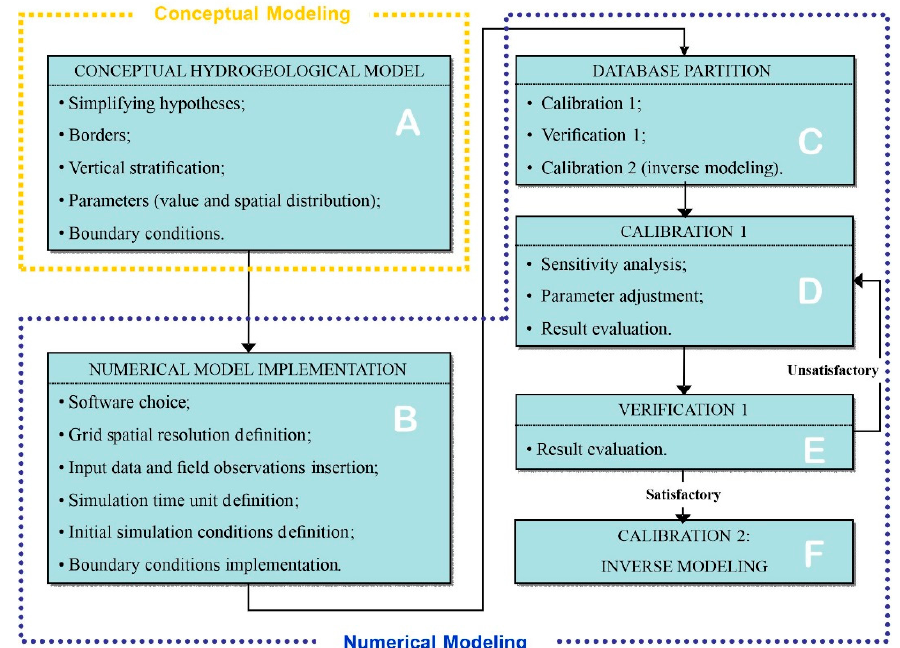
Figure 2. Steps of the numerical modelling method (A: items of the conceptual hydrogeological model, B: steps of the numerical model implementation, C: database partition between modeling steps, D: steps of the calibration process, E: calibration process evaluation, F: recharge estimation by inverse modelling) [41,47].